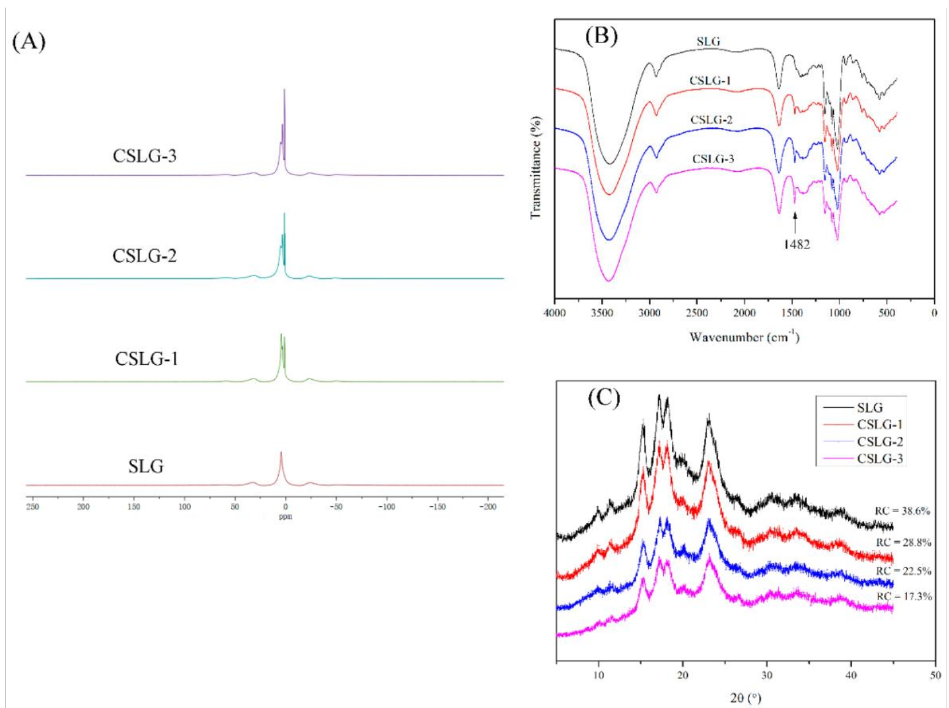
Figure 2. ( A ) the 1 H NMR, ( B ) FTIR, and ( C ) X-ray spectra of SLG and CSLG; Proton nuclear magnetic resonance ( 1 H NMR); cationic short linear glucan (CSLG) 1 mL; 2 mL; 3 mL; short linear glucan